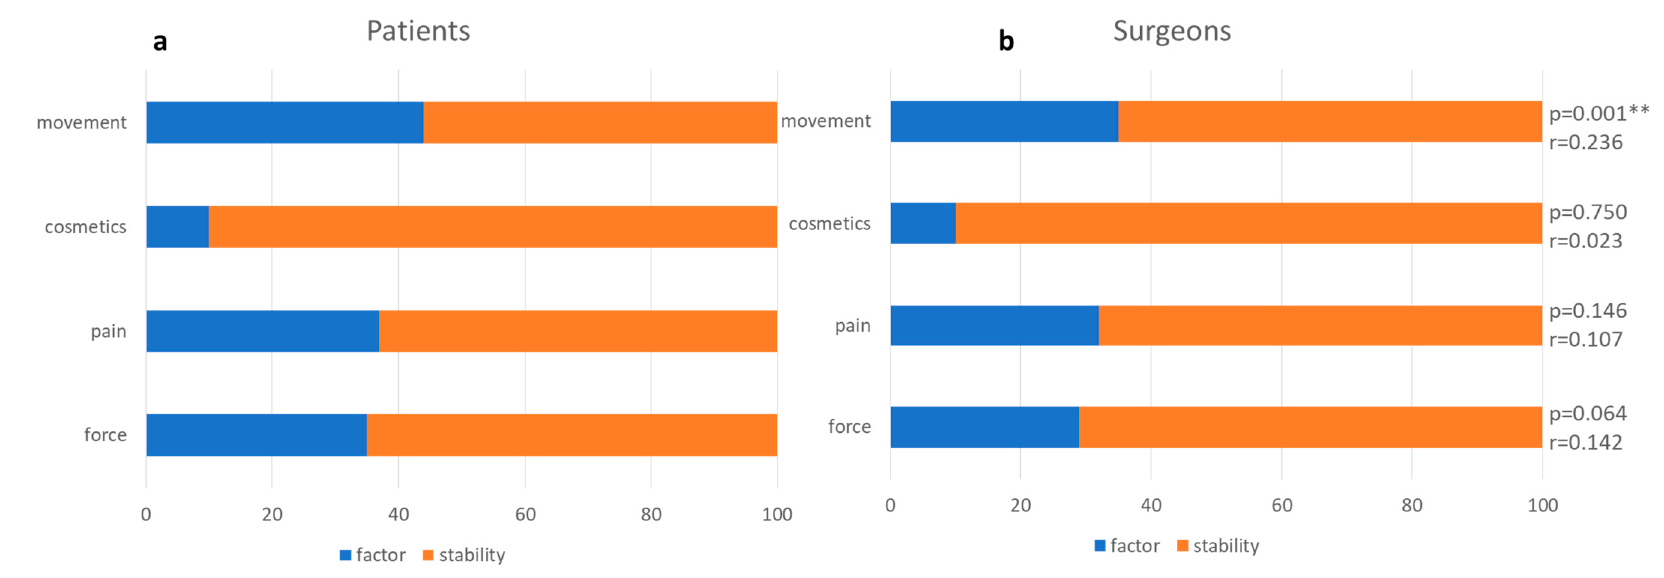
Figure 2. Patients’ ( a ) and surgeons’ ( b ) ratio of importance between stability and other outcome parameters. There was a significant difference in rating movement in comparison to stability between patients and surgeons (** p ≤ 0.01).